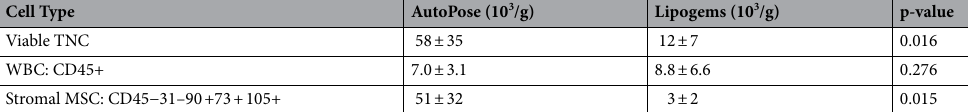
Table 4. Number of outgrowth cells normalized per gram of product 7 days after culture (10 3 /g). Aggregate mean and standard deviation (SD) of data represented as “mean ±